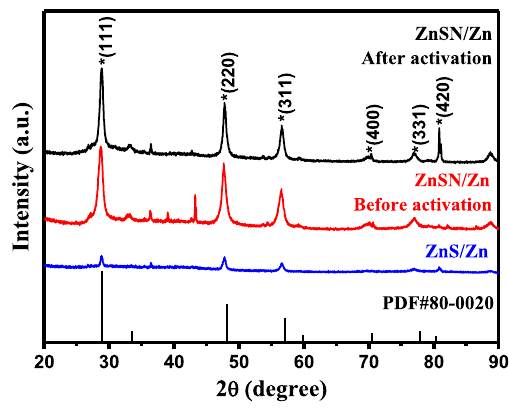
Fig. 2 XRD patterns of N@ZnS/Zn and ZnS/Zn materials